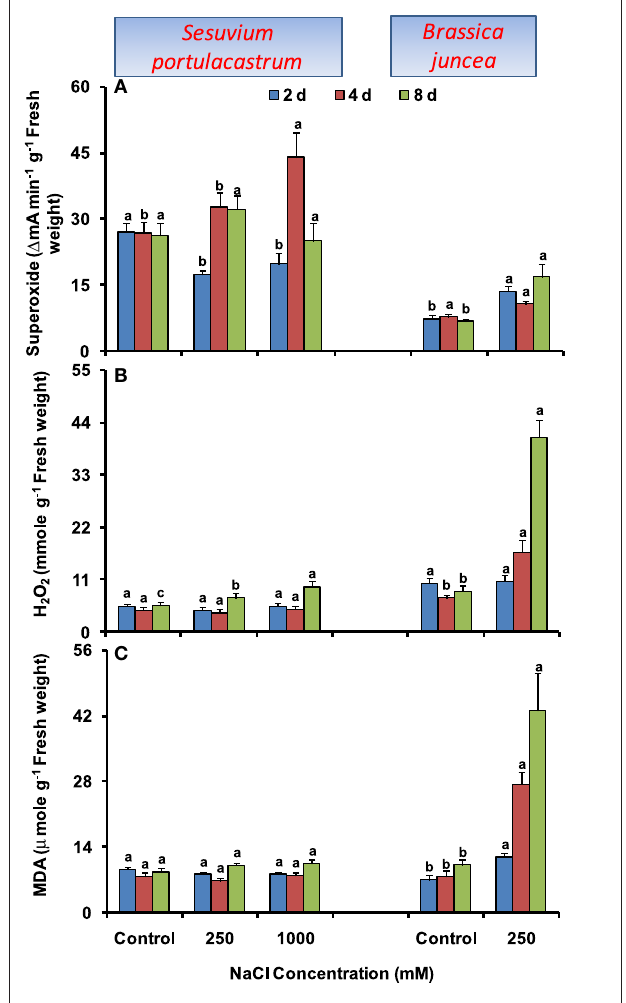
FIGURE 1 | Time dependent modulation of superoxide radicals (A), hydrogen peroxide (B) and malondialdehyde (C) in NaCl-exposed Sesuvium portulacastrum and Brassica juncea . All values represent the mean of three replicates. Different letters indicate significantly different values at a particular duration (DMRT, P = 0